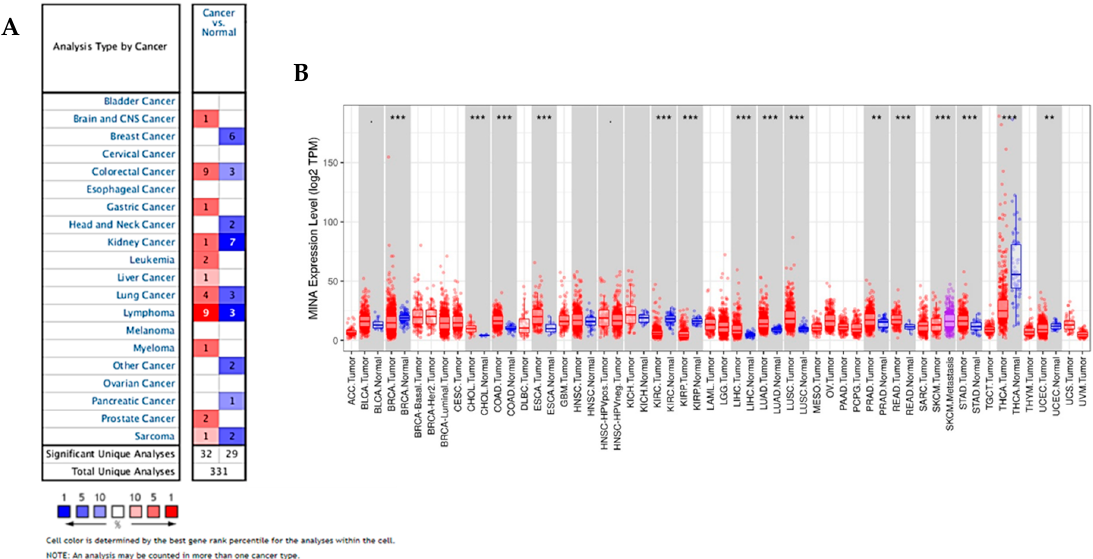
Figure 1. JMJD10 gene expression is upregulated in diverse types of cancer. ( A ) Expression of the JMJD10 gene in common cancers vs. normal tissues using the Oncomine database. The graph, generated by Oncomine, represents the number of statistically significant datasets ( p < 0.01) overexpressed (red) or underexpressed (blue) in JMJD10 mRNA (cancer vs. corresponding normal tissue). The threshold was designed with the following parameters: p -value < 0.01, fold change = 1.5, and gene rank = Top 10%; the numbers in the boxes indicate the number of analyses that met the thresholds. ( B ) Expression of JMJD10 in cancer vs. normal tissues in various TCGA tumors using the DiffExp module in TIMER.